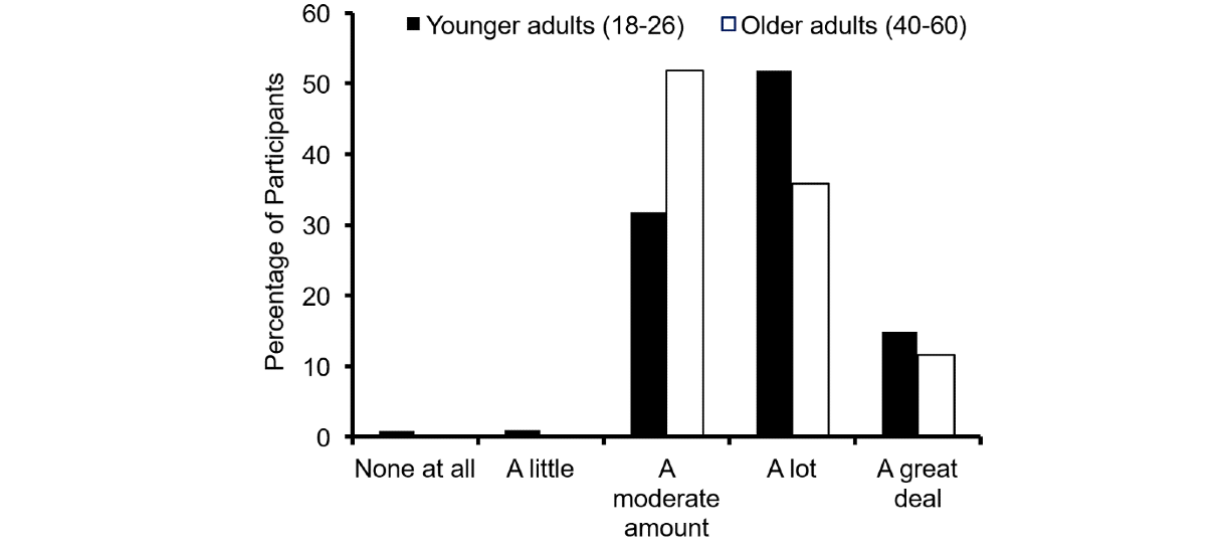
Figure 2. Effect of age on appearance motivation. Change in motivation to eat fruit and vegetables as a result of seeing the demonstration images for two age groups. Younger adults were more positively motivated than older